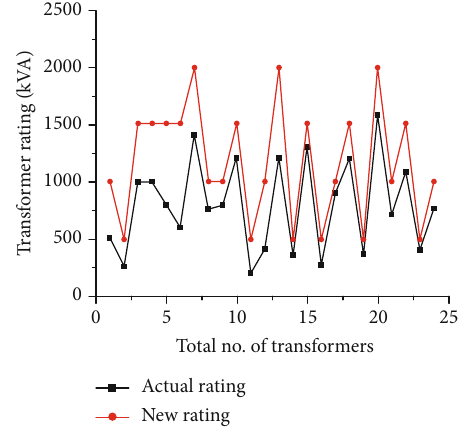
Figure 18: Actual and new rating of transformers in zone